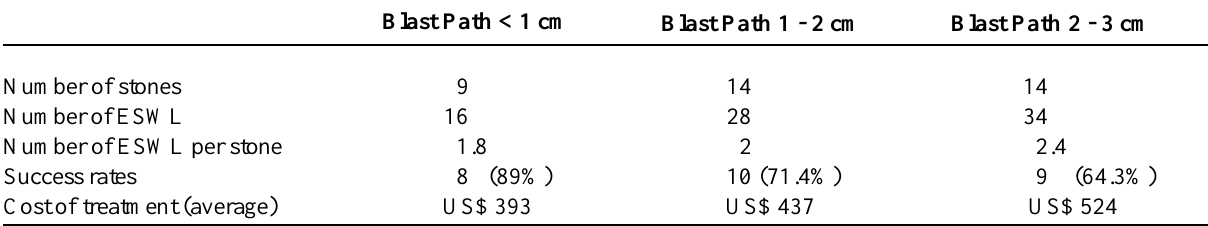
Table 2 – The summary of the outcome and cost of ESWL in the treatment of pelvicalyceal stones sized between 6 - 20 mm in morbidly obese patients according to the position of the stone in relation to the focus of the shock waves (blast